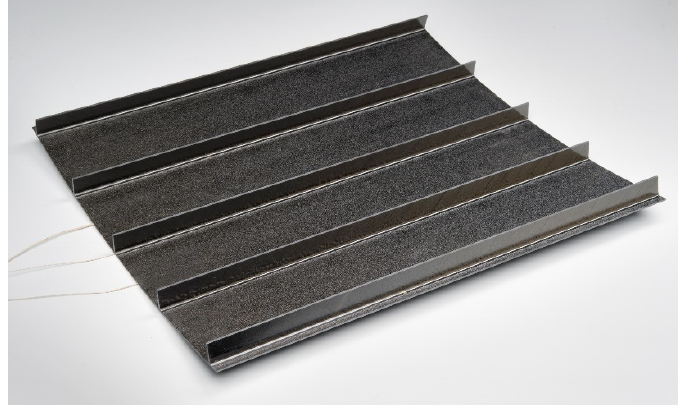
Figure 2. Validation structure to understand the formation of process-induced deformation and residual stresses at the structural level.